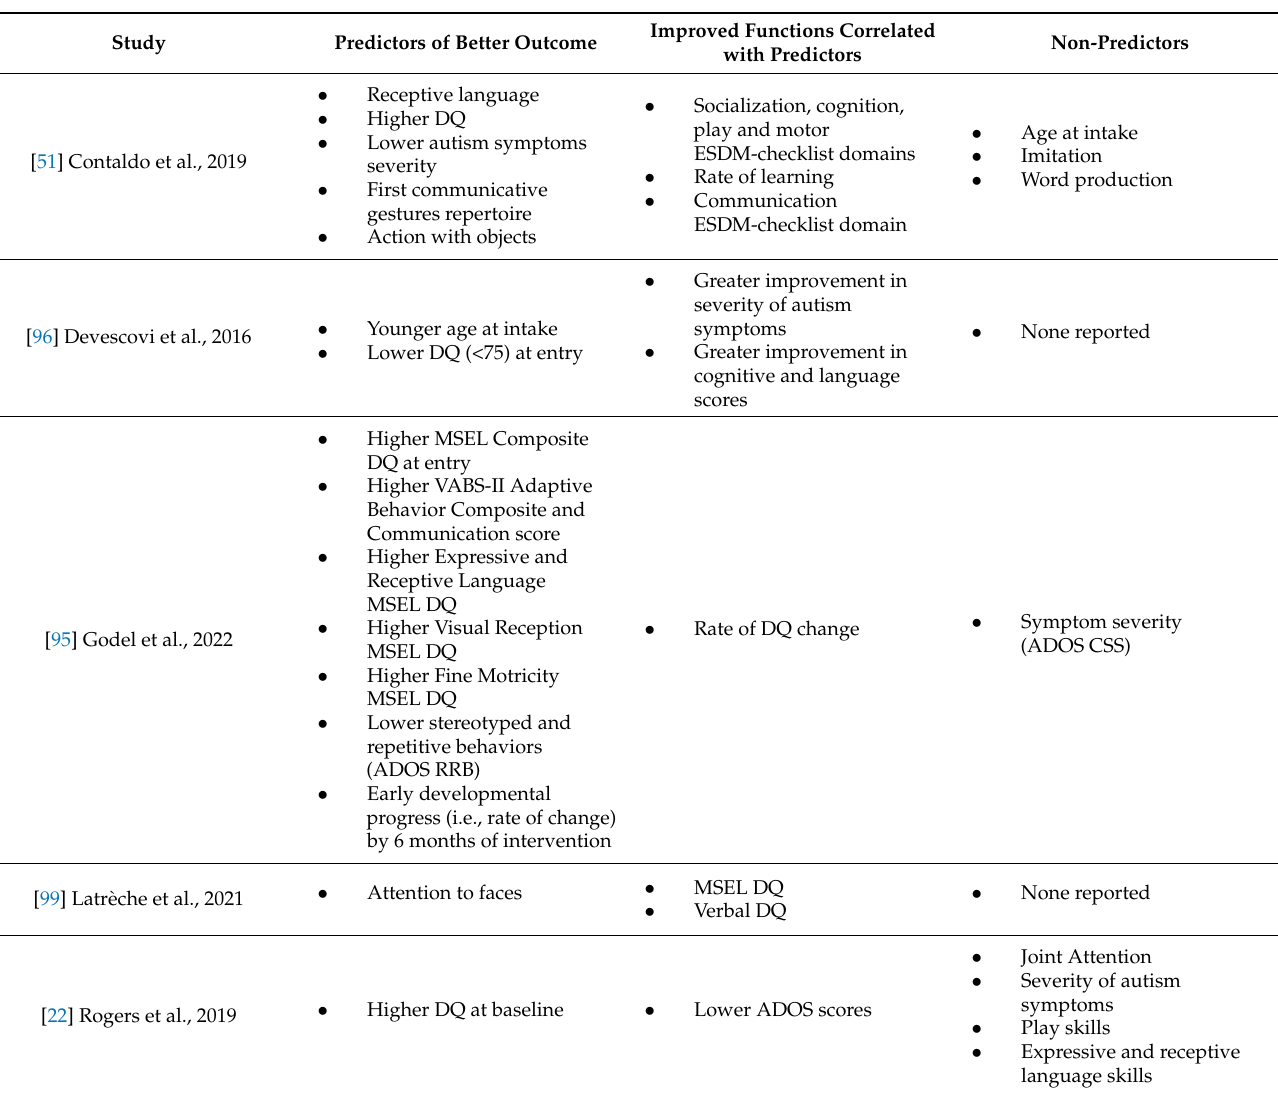
Table 6. Predictors of positive outcome after ESDM